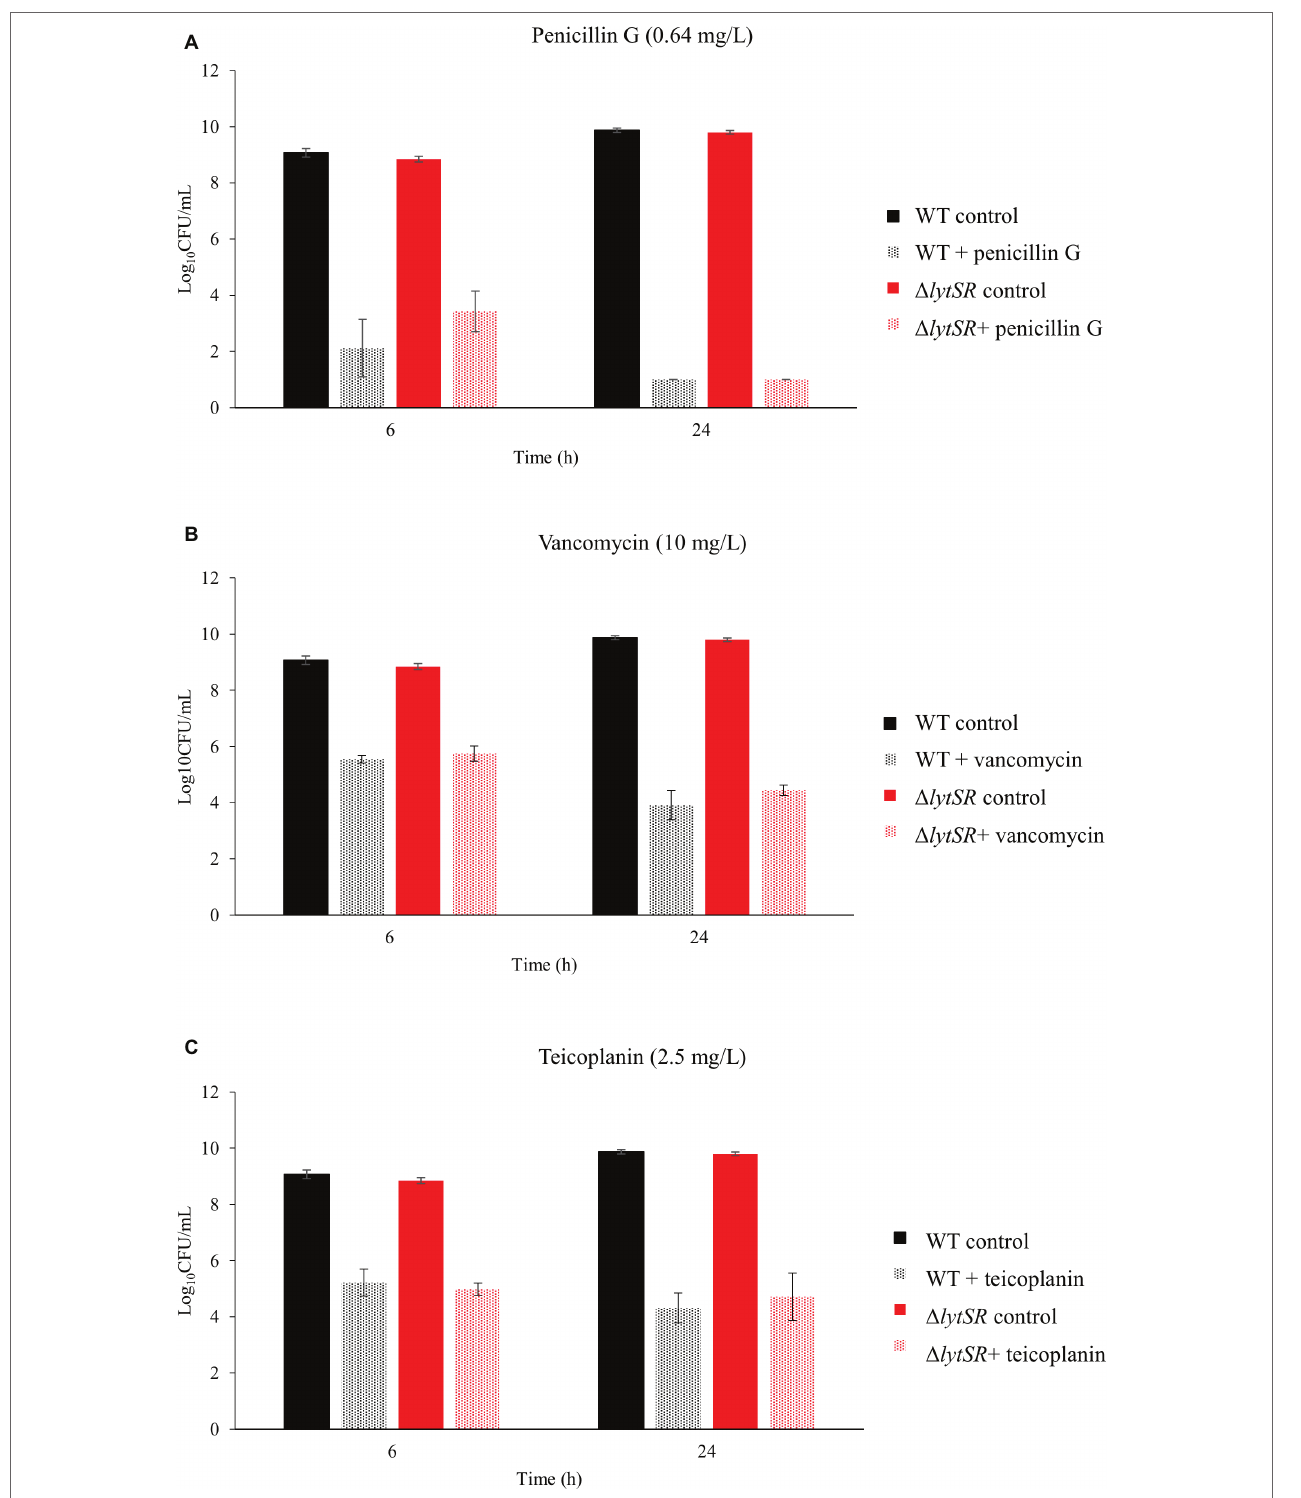
FIGURE 3 | Time-kill kinetics of (A) penicillin G, (B) vancomycin, and (C) teicoplanin against S. lugdunensis WT and Δ lytSR strains. Antibiotics (10 times the MICs) were added to early-exponential growth cultures of the strains. Viable bacterial counts were determined after 6 and 24 h of antibiotic exposure by plating diluted aliquots on TSA. Histograms are expressed as mean ± SD of three independent